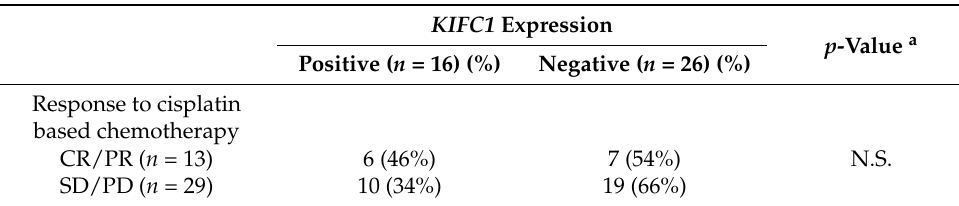
Table 9. Relationship between KIFC1 expression and the response to atezolizumab in IMvigor210 cohort. Table 8. Relationship between KIFC1 expression and the response to cisplatin based chemotherapy in Hiroshima cohort.